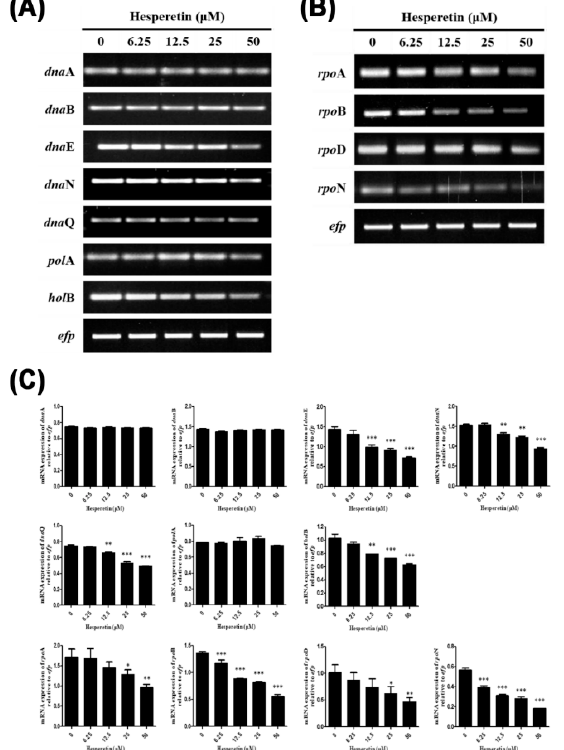
Figure 2 . Downregulation of replication and transcription genes of H. pylori . RNA was subjected to RT-PCR to detect mRNA expression levels of genes of ( A ) the replication machinery ( dna A, dna B, dna E, dna N, dna Q, pol A, and hol B) and ( B ) the transcription machinery ( rpo A, rpo B, rpo D, and rpo